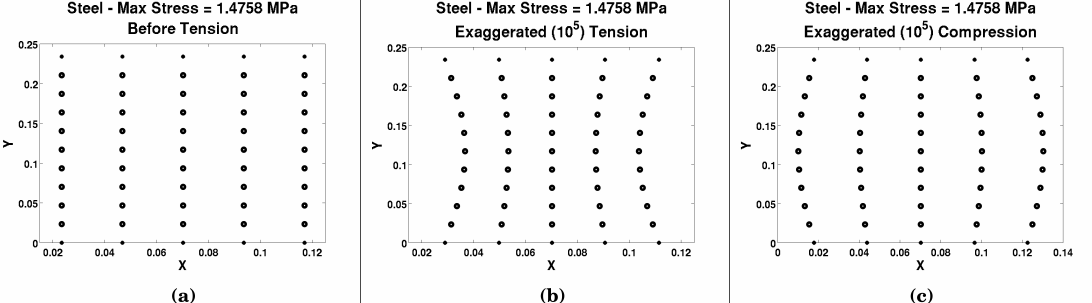
Figure 1. The steel bar ( a ) with no stress, ( b ) in tension, and in ( c ) compression, with 10 5 exaggerated